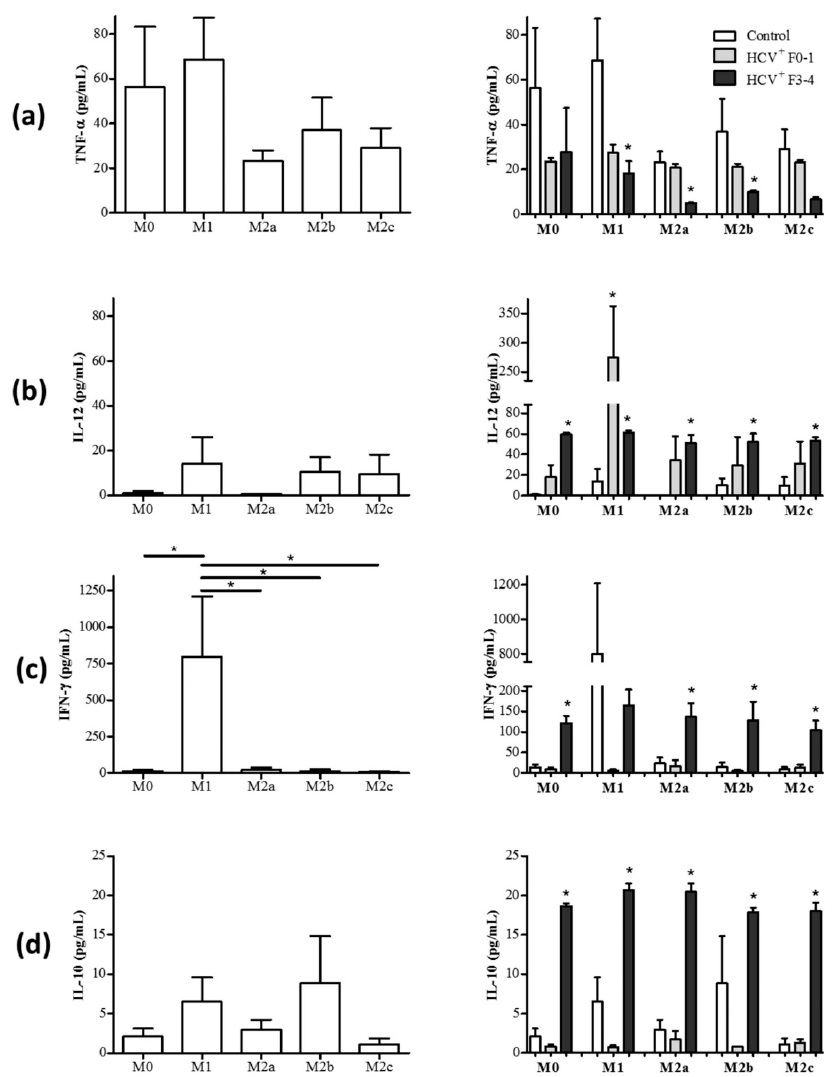
Figure 2. M1 macrophages in HCV-infected individuals acquire M2-like cytokine secretion features while M2 macrophages acquire M1-like cytokine features. Macrophage subsets from healthy controls (HC, n = 6–7) and chronic HCV-infected individuals with minimal liver fibrosis (n = 4) or advanced liver fibrosis (n = 3–4) were cultured for 72 h, after which culture supernatants were collected. The concentration of ( a ) TNF- α , ( b ) IL-12, ( c ) IFN- γ , and ( d ) IL-10 in culture supernatants were quantified using multiplexing immunobead assays. Panels on the left display data relating to the secretion of these cytokines by each macrophage subset as follows: M0, M1, M2a, M2b, and M2c. Panels on the right show data from monocyte-derived macrophage (MDM) cultures derived from HCV + individuals. Statistical significance of cytokine secretion by cells from controls was determined by one-tailed paired Student’s t -test, HCV + groups were compared to uninfected controls using a one-way ANOVA ( p ≤ 0.05), and significant p -values are indicated with an asterisk “*”. Any significant differences between HCV + study groups are also indicated with a line and an asterisk.